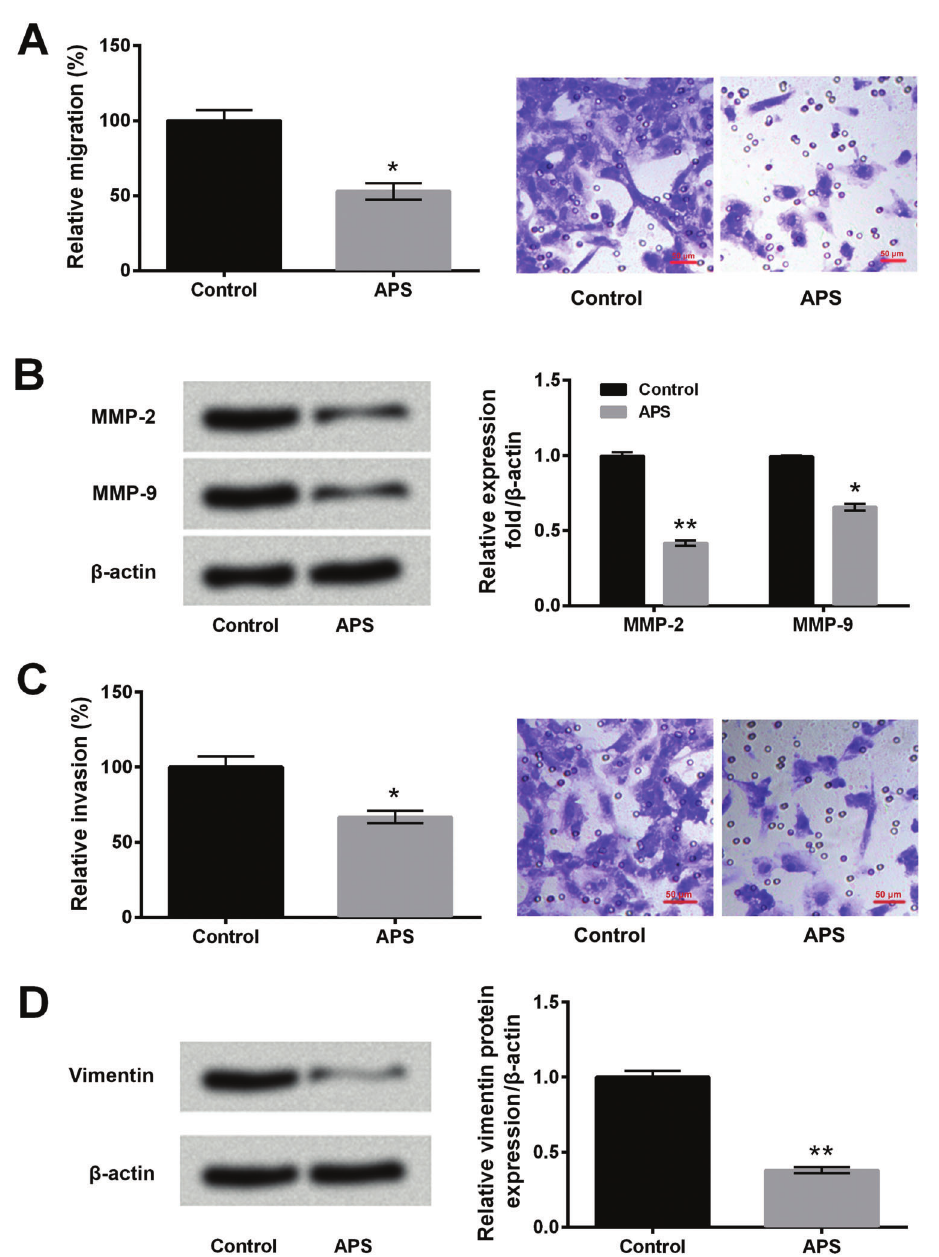
Figure 2. Astragalus polysaccharides (APS) suppressed migration and invasion of MG63 cells. MG63 cells were treated with 10 mg/mL APS. Non-treated cells acted as control. A , Cell migration was measured with the transwell migration assay. B , Expression levels of migration-associated proteins were assessed by western blot analysis. C , Cell invasion was detected with the transwell invasion assay. D, Expression of invasion-associated proteins were evaluated by western blot analysis. MMP: matrix metalloproteinase. Data are reported as means ± SE of three independent experiments. *P o 0.05; **P o 0.01 compared to control ( t-test